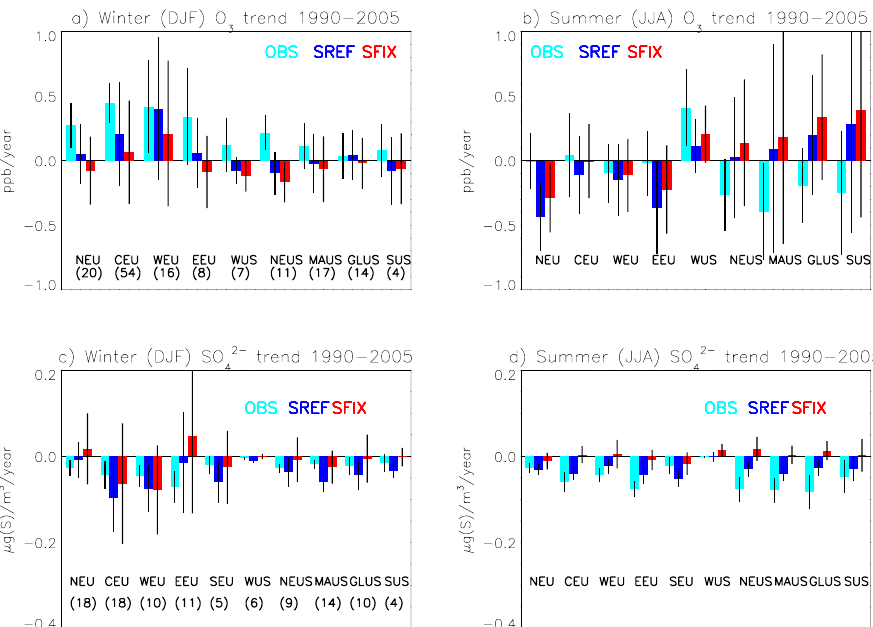
Fig. 6. Trends of the observed (OBS) and calculated (SREF and SIFX) O 3 and SO 2 − seasonal anomalies (DJF and JJA) averaged over 4 each group of stations as shown in Fig. 1: Northern Europe (NEU); Central Europe (CEU); Western Europe (WEU); Eastern Europe (EEU); Southern Europe (SEU); Western US (WUS): North-Eastern US (NEUS); Mid-Atlantic US (MAUS); Great lakes US (GLUS); Southern US (SUS). The vertical bars represent the 95% confidence interval of the trends. The number of stations used to calculate the average seasonal anomalies for each subregion is shown in parentheses. Further details in Appendix